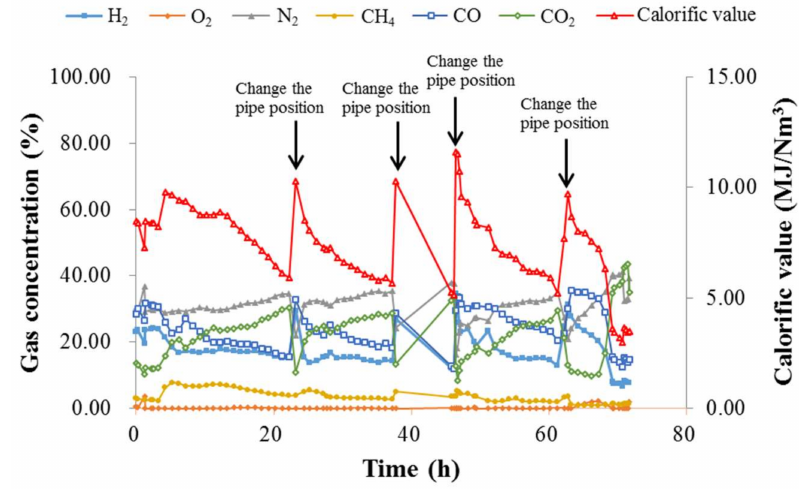
Figure 10. Main compositions and the calorific value of product